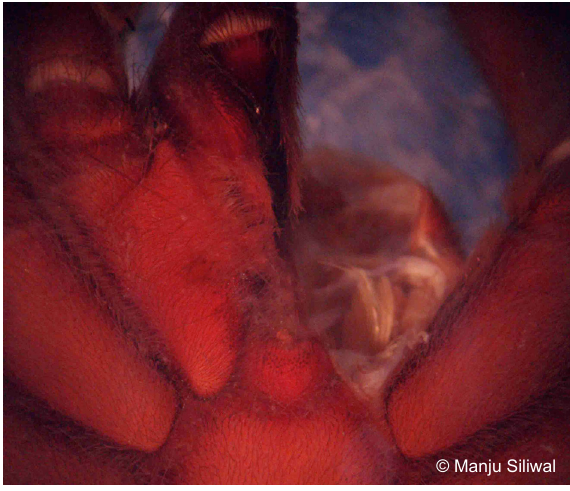
Image 8. Plesiophrictus mahabaleshwari , maxillae, ventral view